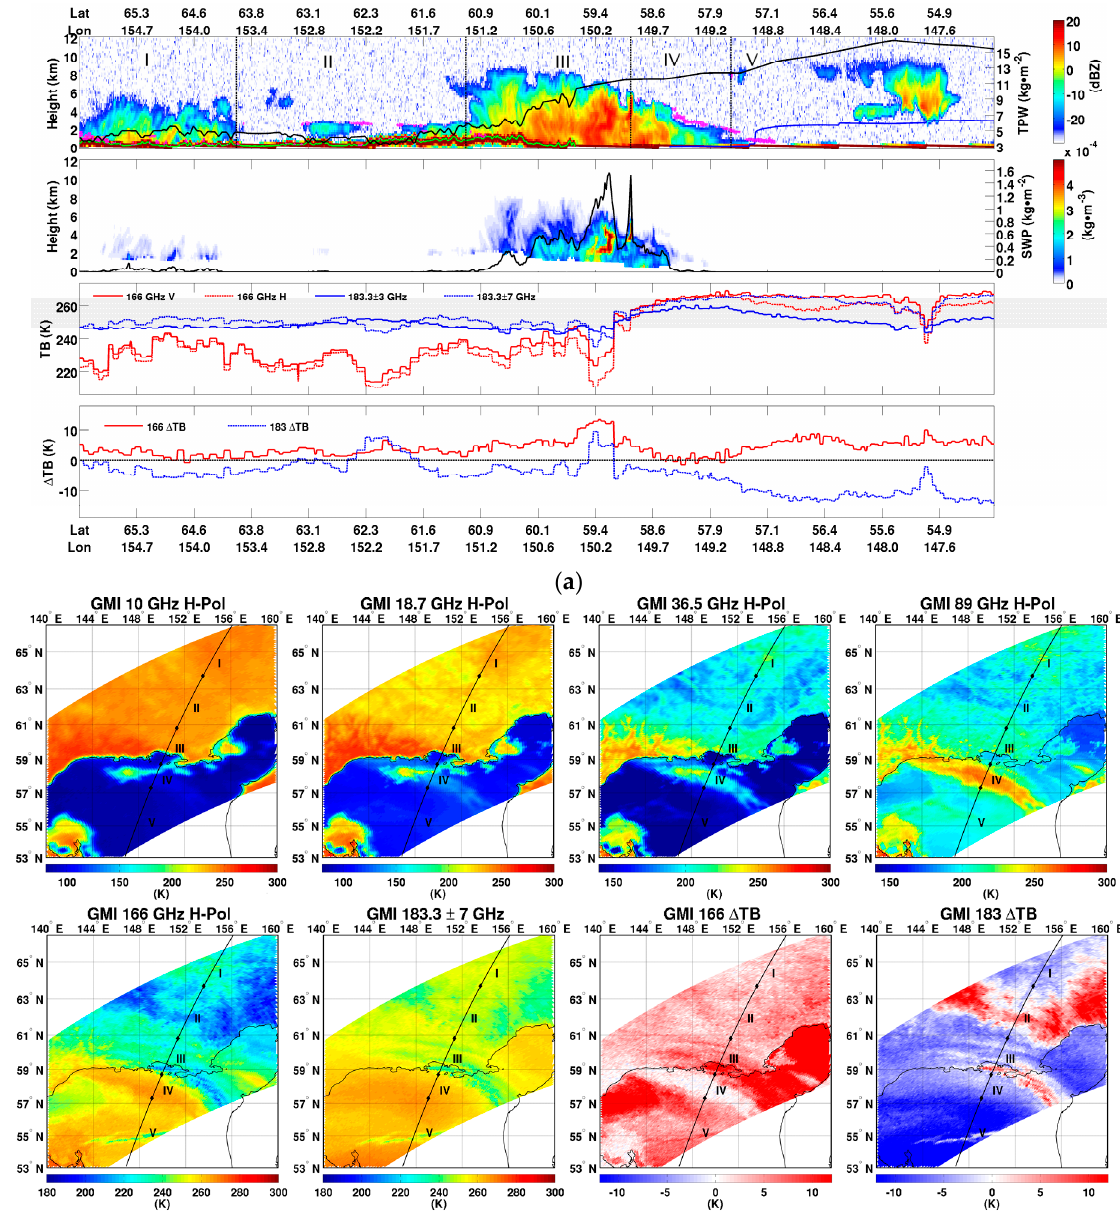
Figure 2. Snowfall event on 30 April 2014. ( a ) From top to bottom, the first panel shows height-lat/lon imagery of Cloud Profiling Radar (CPR) reflectivity (color bar, in dBZ), the freezing level height (blue curve), and total precipitable water (TPW) (black curve, with values provided on the right-hand side y-axis), along the CloudSat track. In this panel, cloud layers where the DARDAR product identifies supercooled droplets are superimposed and shown in magenta. Second panel shows height-lat/lon imagery of 2C-SNOW snow water content (SWC) (color bar, in kg·m − 3 ) and the snow water path (SWP) (black curve, with values provided on right-hand side y-axis). The third panel shows the GMI brightness temperatures (TBs) closest to each CPR pixel along the CloudSat track at 166 GHz (V and H polarization, in red), 183.3 ± 3 GHz and 183.3 ± 7 GHz (in blue). Bottom panel shows GMI TB difference ( ∆ TB) at 166 GHz (V-H, in red), and for the two 183.3 GHz channels (in blue). In the top panel, vertical lines delineate different Sectors (I to V) identified in the discussion (see text for details). ( b ) GMI TB imagery: top row from left, 10, 18.7, 36.5, and 89 (H-pol) channels; bottom row from left: 166 (H-pol) and 183.3 ± 7 channels, ∆ TB at 166 GHz (V pol − H pol) and at 183.3 GHz (183.3 ± 3 GHz–183.3 ± 7 GHz). The black line segment in each panel shows the CloudSat track. The sectors (I to V) identified in the discussion are also indicated (see text for details).